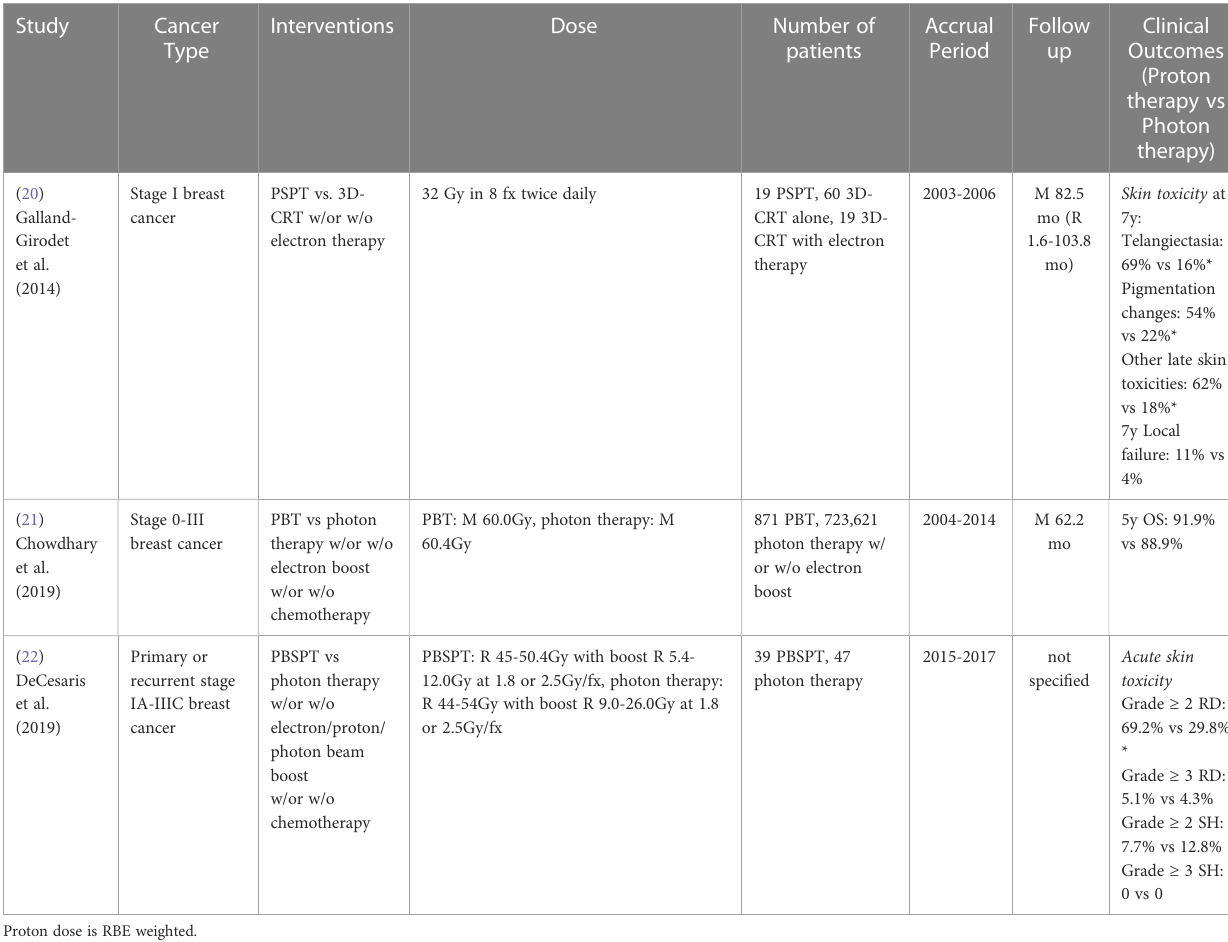
TABLE 2 Non-randomized clinical studies of proton versus photon radiation therapy – breast